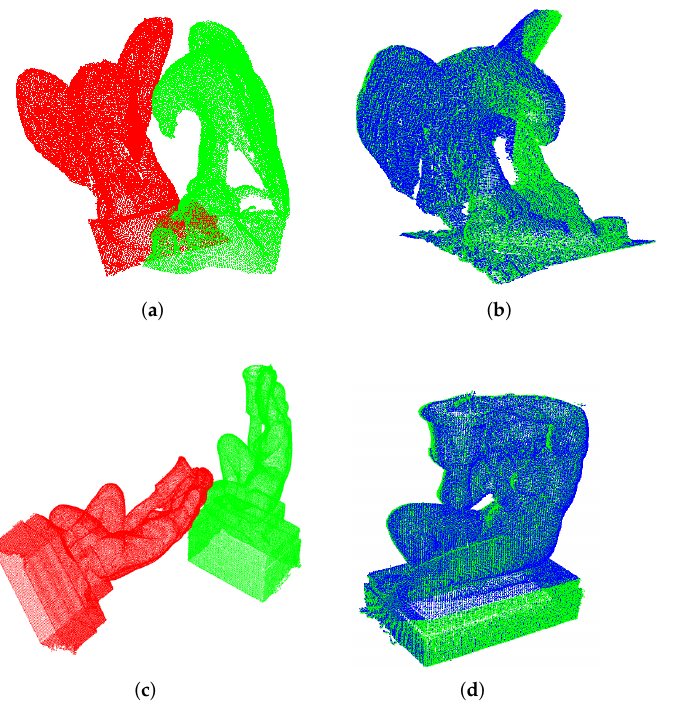
Figure 6. Registration of partial views of the Eagle and Aquarius models under rotational phe- nomena on generic axes. ( a ) Initial pose (Eagle). ( b ) UPS (Eagle). ( c ) Initial pose (Aquarius). ( d ) UPS